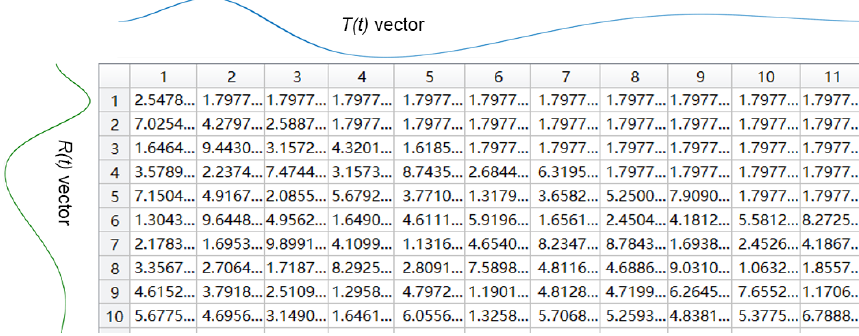
Figure 7. The squared Euclidian distance matrix between two time series signals.